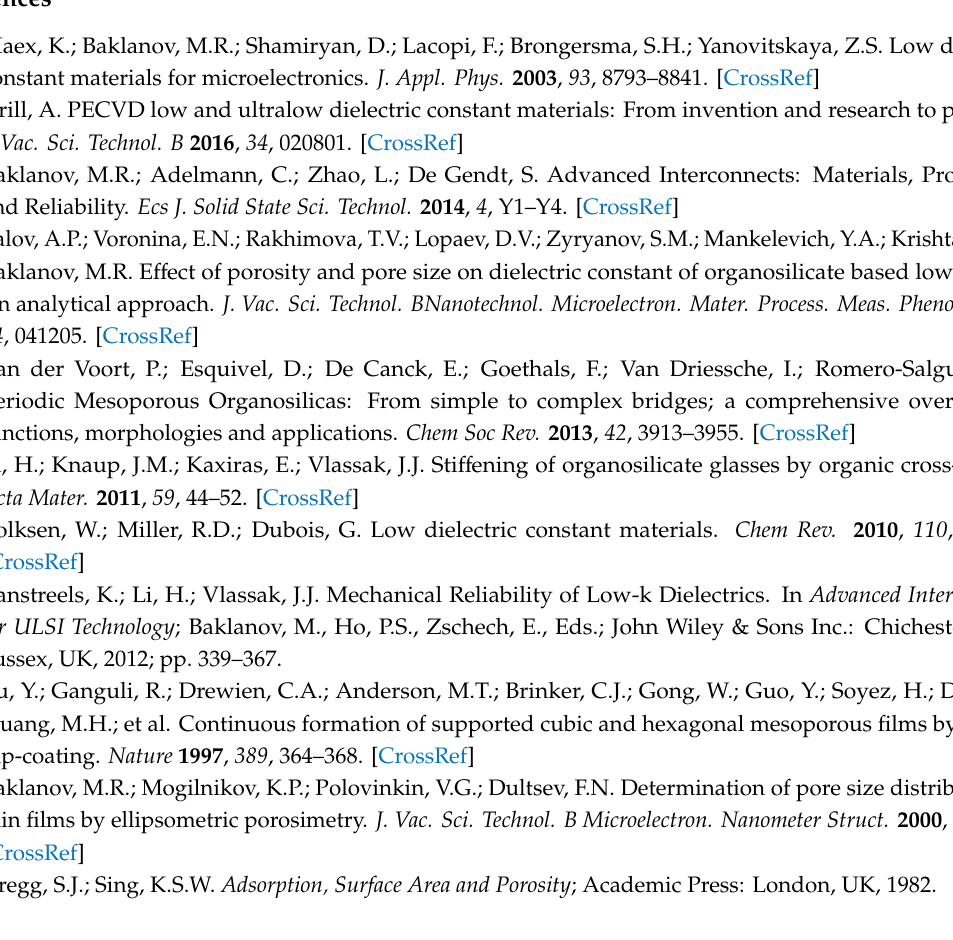
Table S1: UV-Vis optical characteristics of porous organosilicate glass films with di ff erent types and content (25 and 45 mol%) of bridging groups, cured at 430 ◦ C for 30 min in air, Table S2: The summarized FTIR data for porous methylsilsesquioxane film (MSSQ) and organosilicate glass films with di ff erent types (M—methylene, E—ethylene, B—1,4-phenylene) and content (0–100 mol%) of bridging groups, annealed at 430 ◦ C for 30 min in air (hard bake), Table S3: Water contact angle values for porous methylsilsesquioxane film (MSSQ) and some of the organosilicate glass films deposited with di ff erent ratios of 1,2-bis(trimethoxysilyl)ethane to methyltrimethoxysilane (BTMSE / MTMS) mixture, annealed at 430 ◦ C for 30 min in air (hard bake), Table S4: open porosity V open and pore radius ( R ) distribution measured by ellipsometric porosimetry, Figure S1: SEM picture of organosilicate glass material with terminal methyl groups (30% porosity) deposited on top of Cu, Figure S2: The measured dielectric constants versus porosity and comparison with the Clausius–Mossotti equation plotted for SiO 2